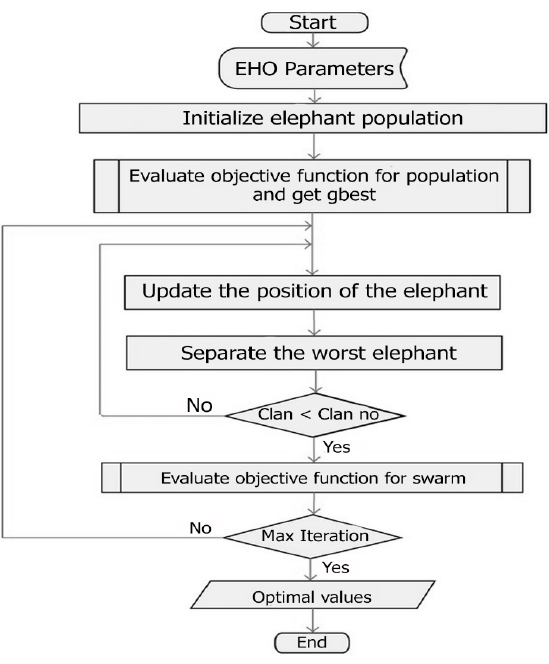
Figure 4 . Pseudocode for EHO procedure.